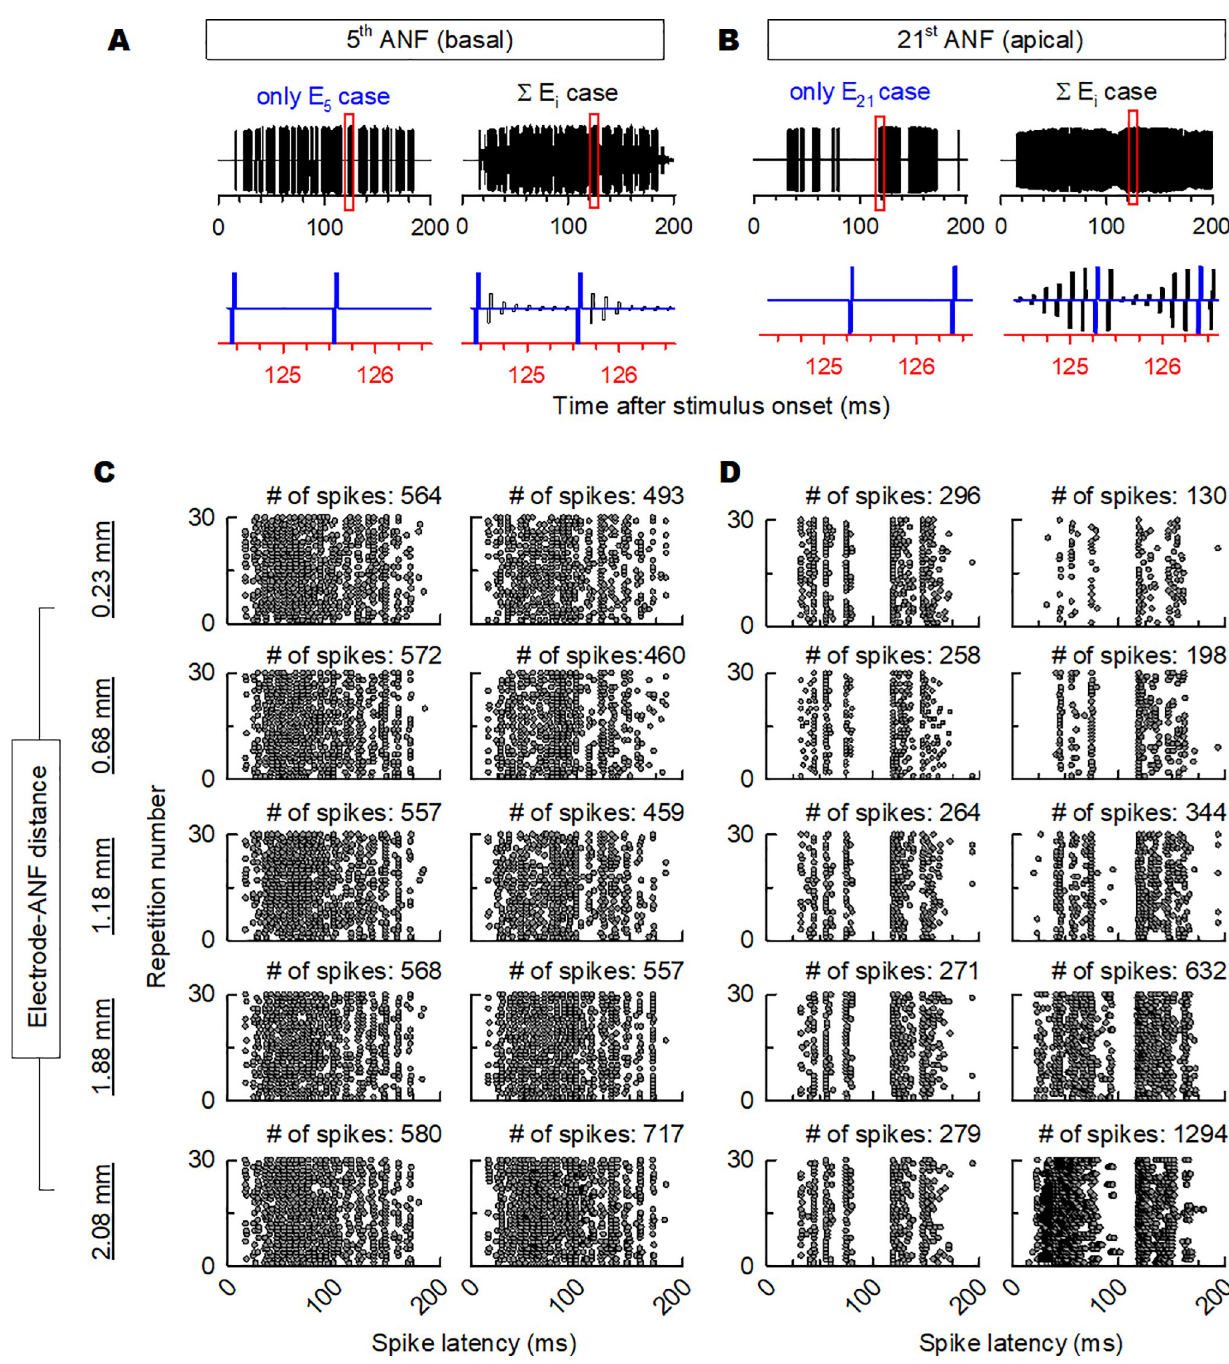
Fig 6. Example of the stimulation pulses and dot raster plot of the spike activity for 30 repetitions over the stimulus time for the 5th ANF in the basal region and 21st ANF in the apical region. Panels A and B show the stimulation pulses over a time interval defined by a window of 200 ms and a window of 124–127 ms, respectively (red square in the stimulation pulses of 200 ms). The left columns of panels A and B present the stimulation pulses from only the 5th and 21st channels, respectively (blue line in detailed stimulation pulses), while the right columns of panels A and B show the stimulation pulses including those from the neighboring channels due to current spread (black line in detailed stimulation pulses). Panels C and D show the spike activity for each stimulation in panels A and B, respectively.